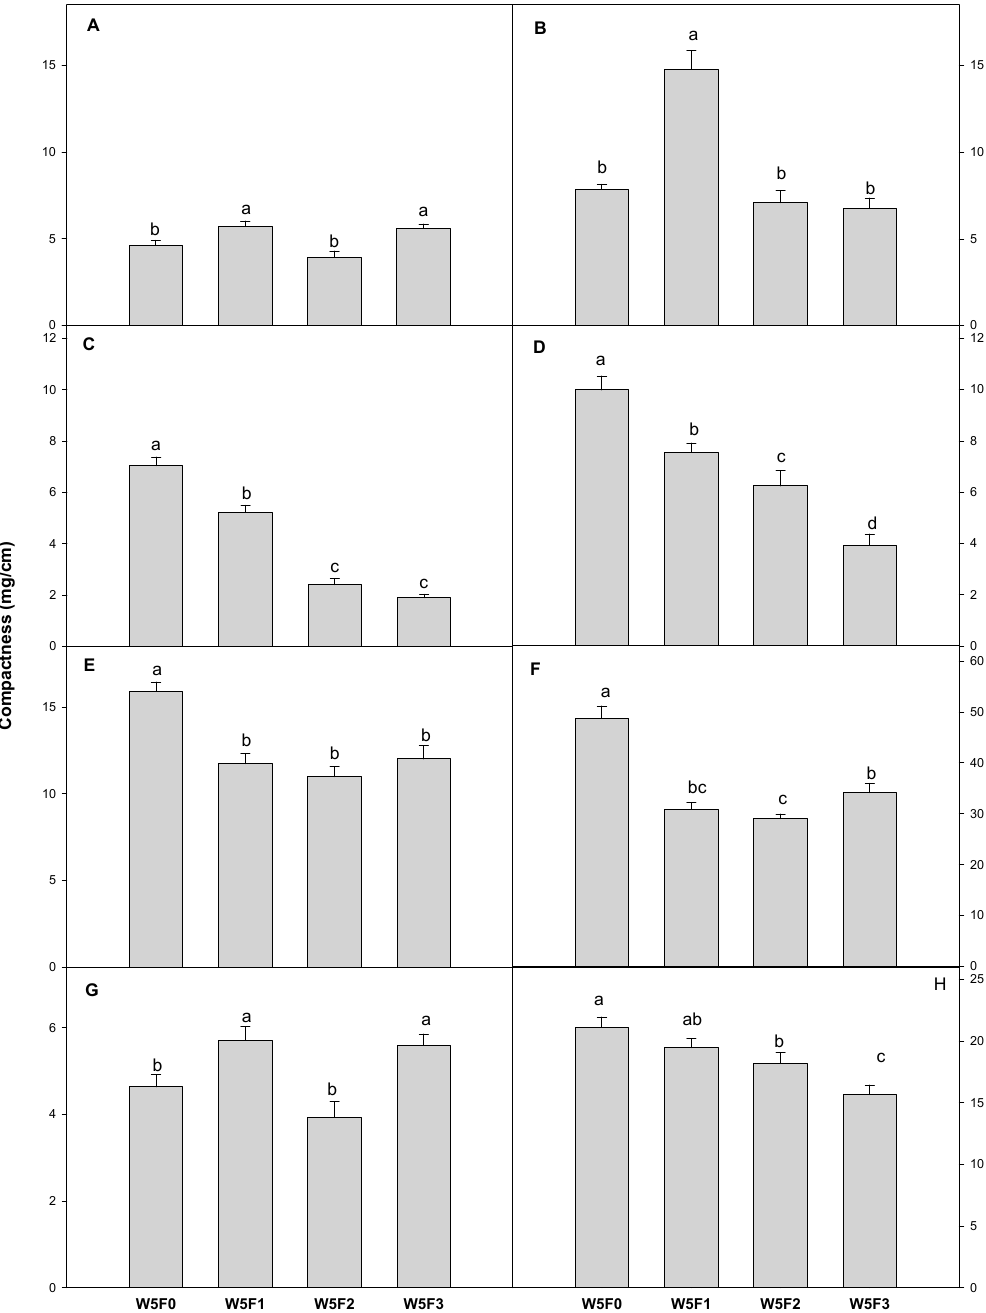
Figure 3. Compactness of tomato “Dotaerangdia” ( A ) and “B-blocking” ( B ) at 14 days after sowing (DAS), red pepper “Shinhong” ( C ) and “Tantan” ( D ) at 14 DAS, cucumber ( E ) and gourd ( F ) at 7 DAS and watermelon ( G ) and bottle gourd ( H ) at 9 DAS by the different supplemental far-red-enriched LED lighting. Data represent the mean of three replications with eight plants per replication per species. Vertical bars represent standard errors of means. Mean separation among treatments within each cultivar by Duncan’s multiple range test at α < 0.05.